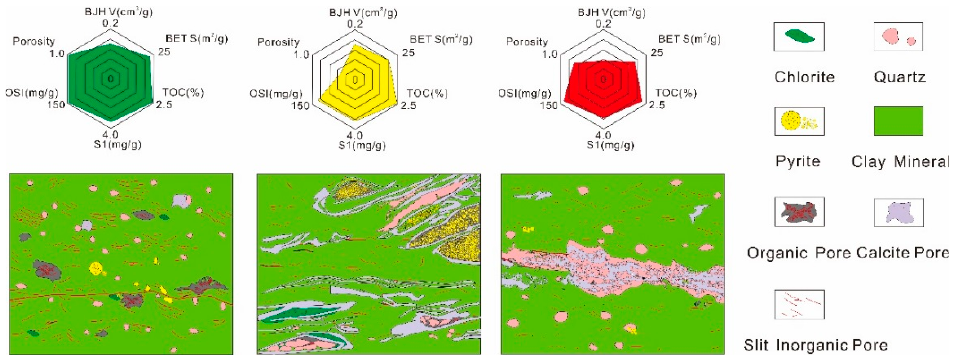
Figure 9. Distribution of mineral composition, reservoir, and oil-bearing patterns for different laminae.